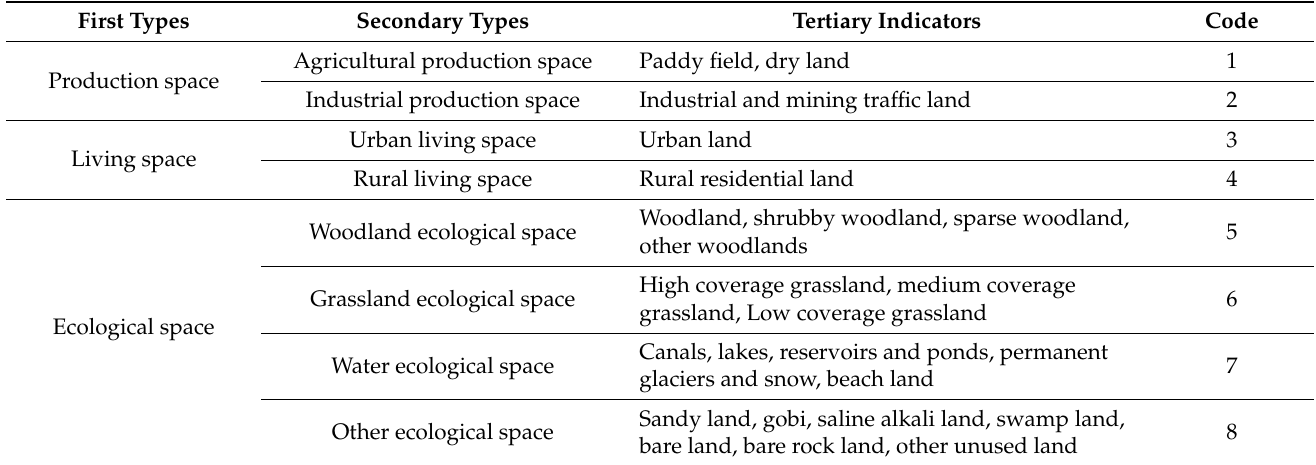
Table 1. Classification of PLES function based on dominant